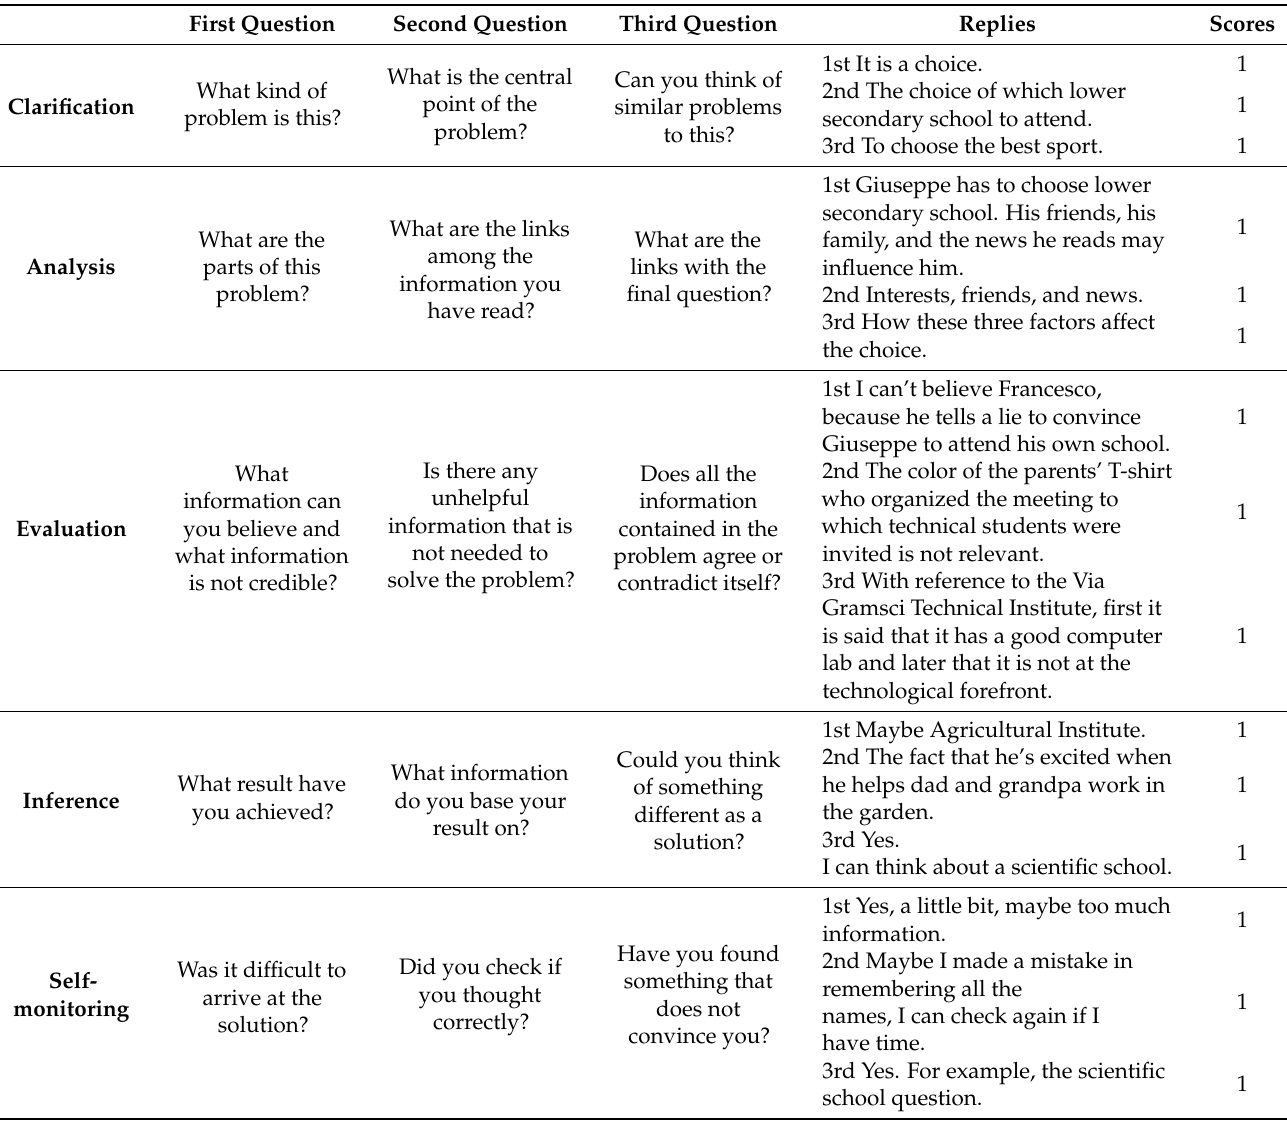
Table 3. Scoring for each question of the social